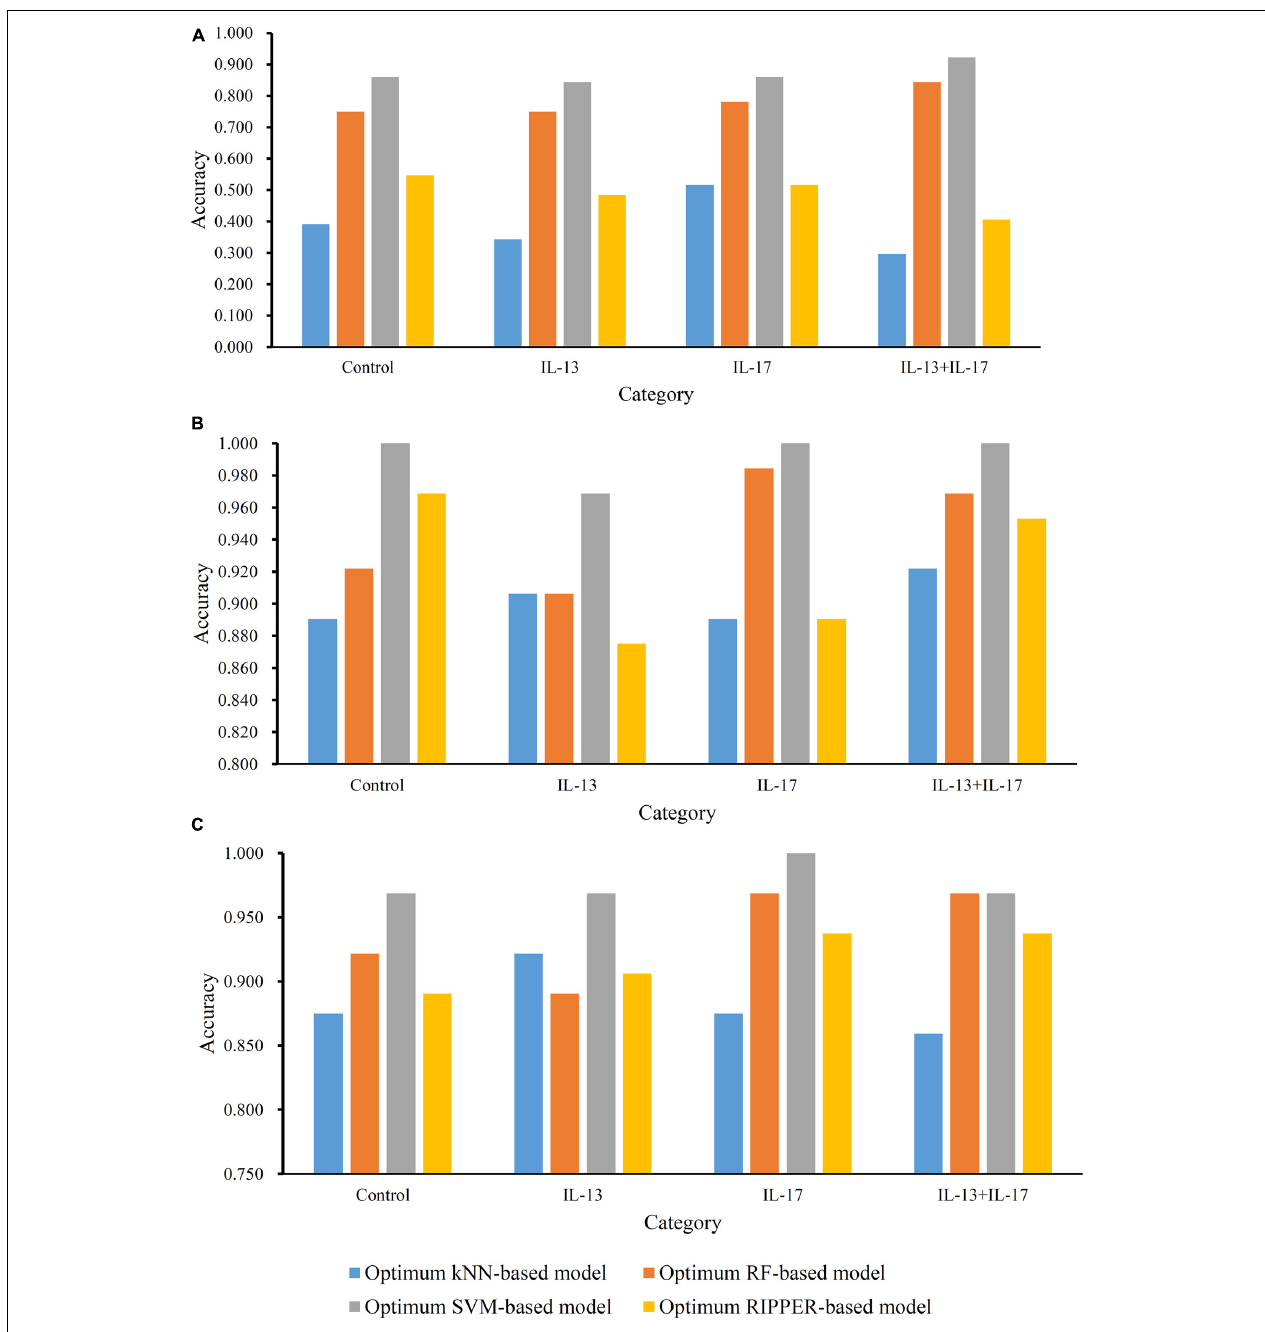
FIGURE 3 | Accuracies on all categories yielded by the optimum classifiers on three datasets. (A) Methylation data; (B) gene expression data; (C) combined